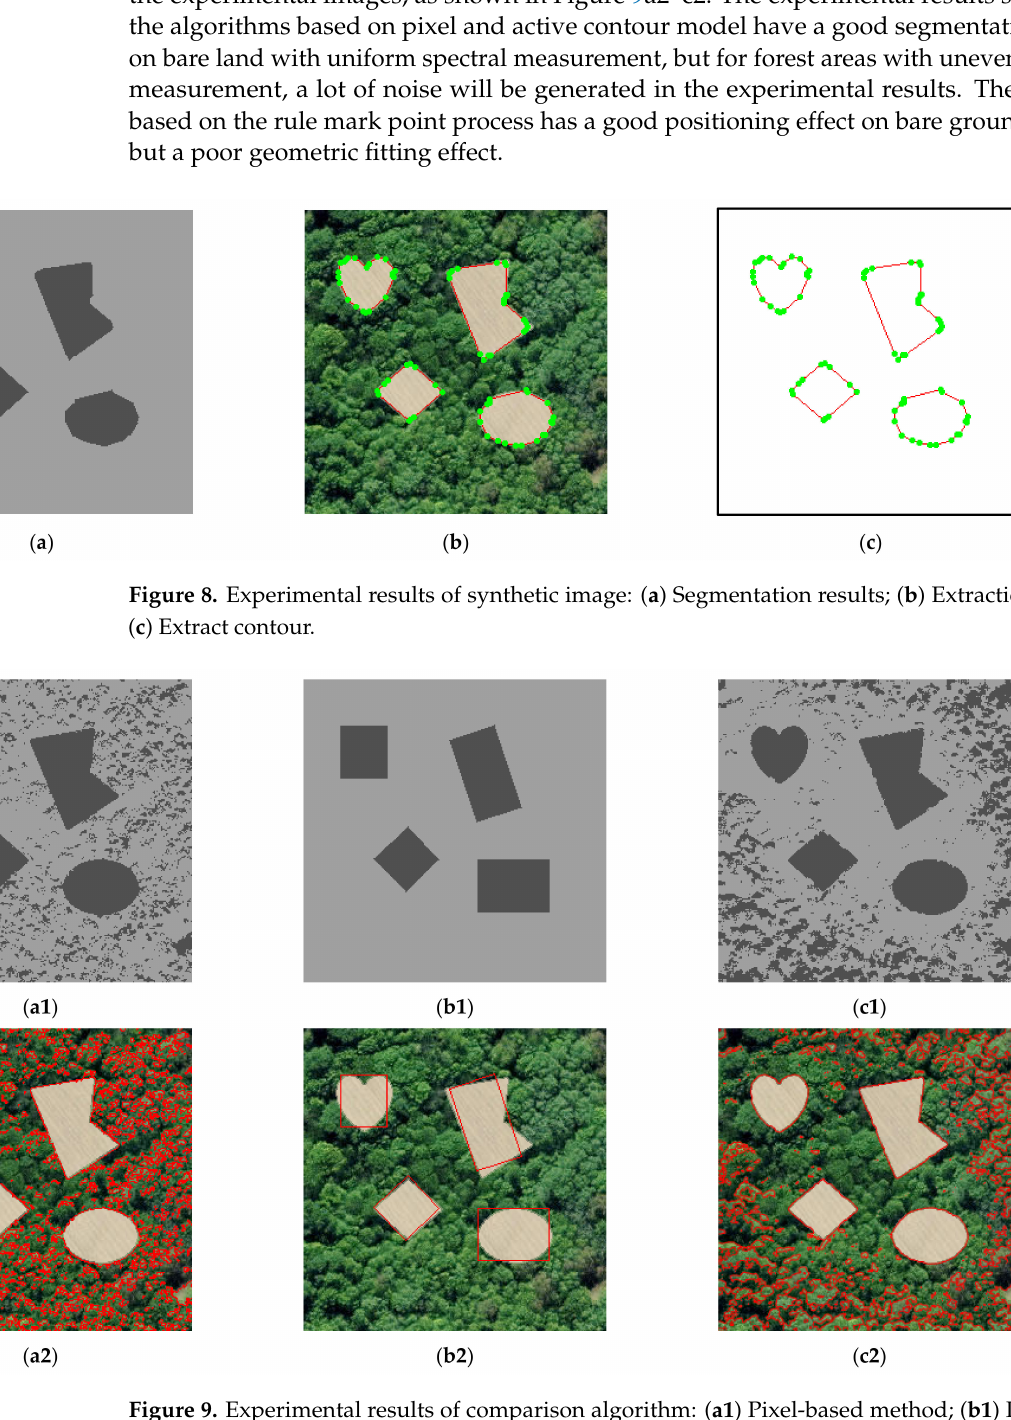
Figure 9. Experimental results of comparison algorithm: ( a1 ) Pixel-based method; ( b1 ) Rule mark point process; ( c1 ) Active contour model; ( a2 ) Object detection results based on pixel method; ( b2 ) Object detection results based on rule mark point process; ( c2 ) Object detection results based on active contour